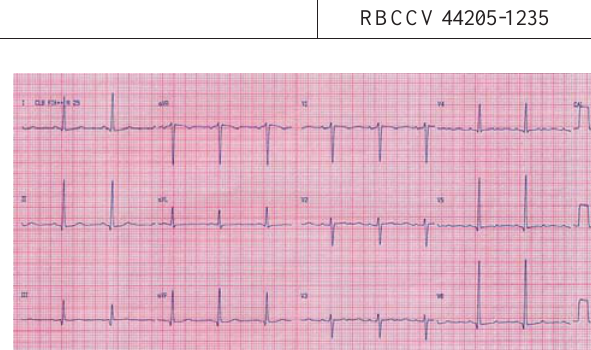
Fig. 1 – Eletrocardiograma pré-operatório com sobrecarga ventricular